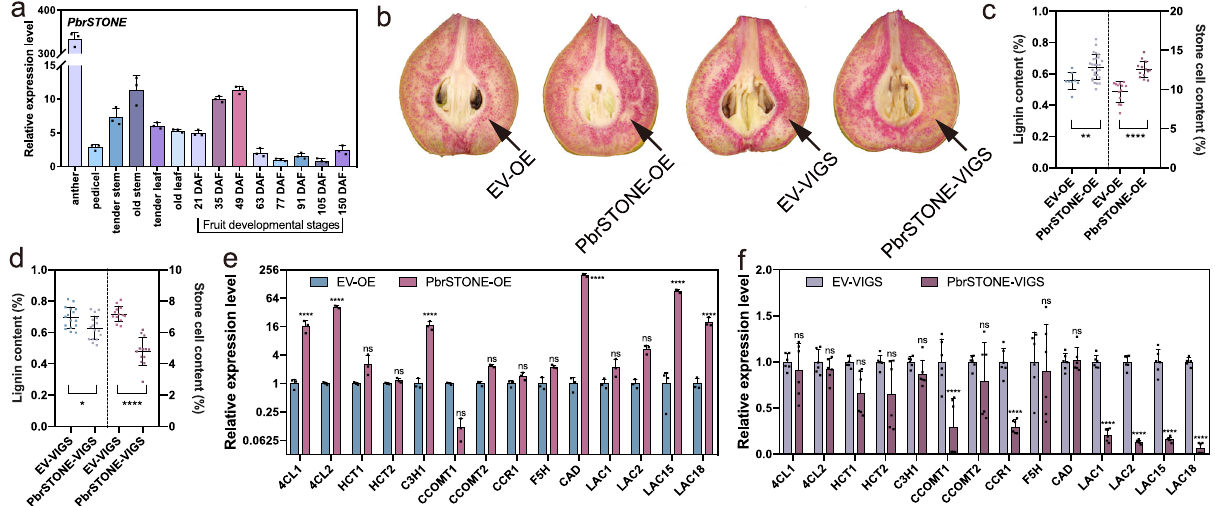
Fig. 5 Functional validation of PbrSTONE in controlling stone cell content and lignin of pears. a Expression pro fi les of PbrSTONE in different tissues of ‘ Dangshansuli ’ plants determined by q-RT-PCR; n = 3 biologically independent samples. b Transient assays using PbrSTONE overexpression and silencing constructs in ‘ Dangshansuli ’ fruit at 35 days after fl owering (DAF). Images were taken at 10 days after agro-in fi ltration. c , d Lignin and stone cell contents in the fl esh tissue around the in fi ltration sites. More than six fruits were injected with each construct in an experiment that was repeated three times. EV empty vector, OE overexpression, VIGS virus-induced gene silencing. For lignin content, n = 8, 27, 16, and 16 biologically independent samples for EV-OE, PbrSTONE - OE, EV-VIGS, and PbrSTONE -VIGS, respectively. For stone cell content, n = 13 biologically independent samples for all lines. e , f Expression levels of genes encoding enzymes involved in monolignol biosynthesis and polymerization in the fl esh tissue around the in fi ltration site using qPCR analysis; n = 3 biologically independent samples for EV-OE and PbrSTONE -OE, and n = 6 for EV-VIGS and PbrSTONE -VIGS. Data presented are mean±SD; p -values were determined by two-tailed Student ’ s t -test (* p <0.05, ** p <0.01, *** p <0.001, **** p <0.0001; ns, not signi fi cant). Source data are provided as a Source Data fi